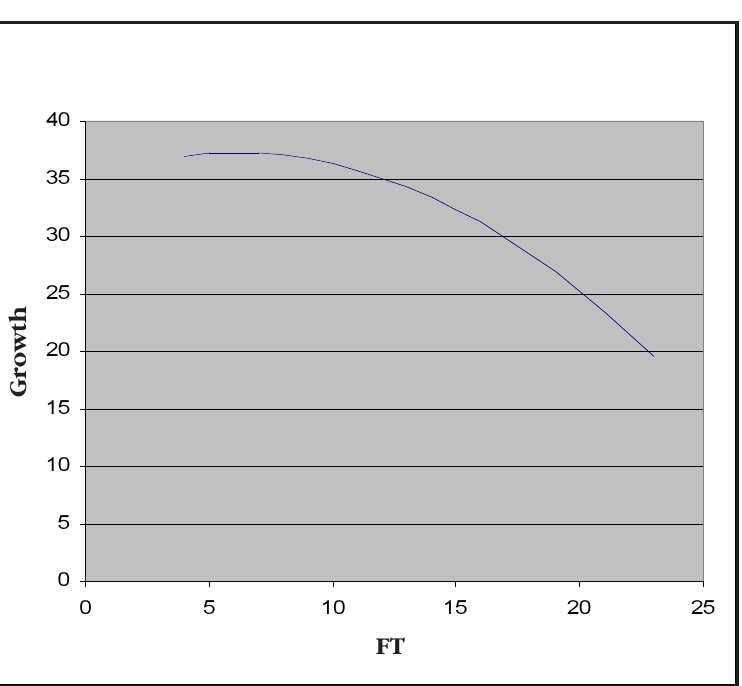
Figure 2. Growth vs. FT